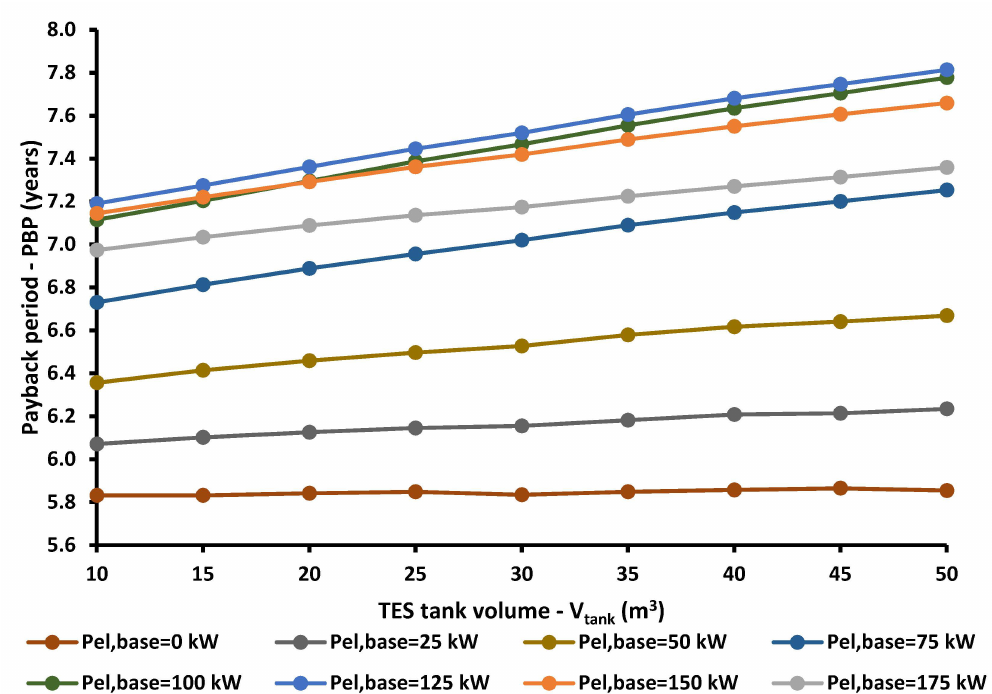
Figure 14. Payback period for different values of net electricity load and TES tank volume when the hydrogen price is equal to 25